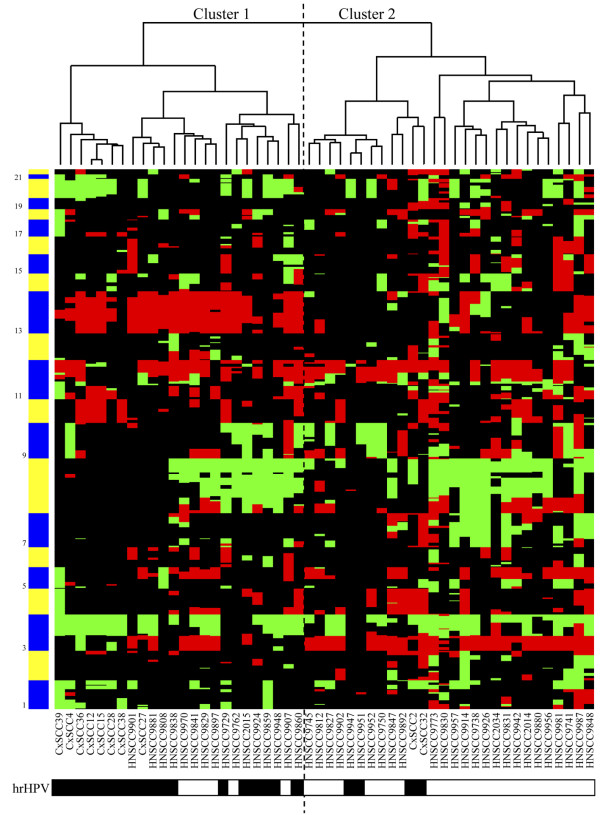
Result from the unsupervised hierarchical clustering analysis. Cluster 1 contains in majority hrHPV-positive carcinomas, as is indicated by the black boxes in the legend underneath the heatmap (p < 0.0001).